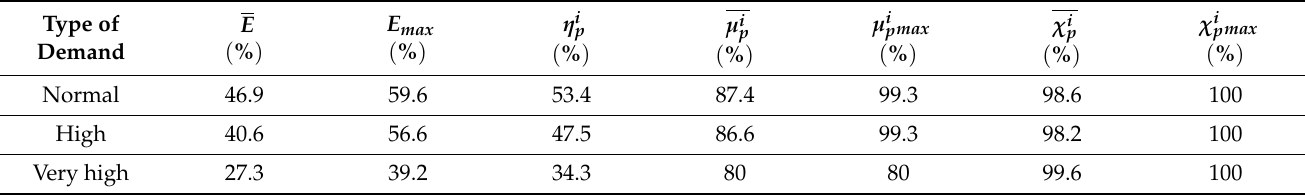
Table 3. Effectiveness ( E ), Capacity ( η i p ), Reliability ( µ i p ) and Sustainability ( χ i p ) for different con- sumption scenarios.